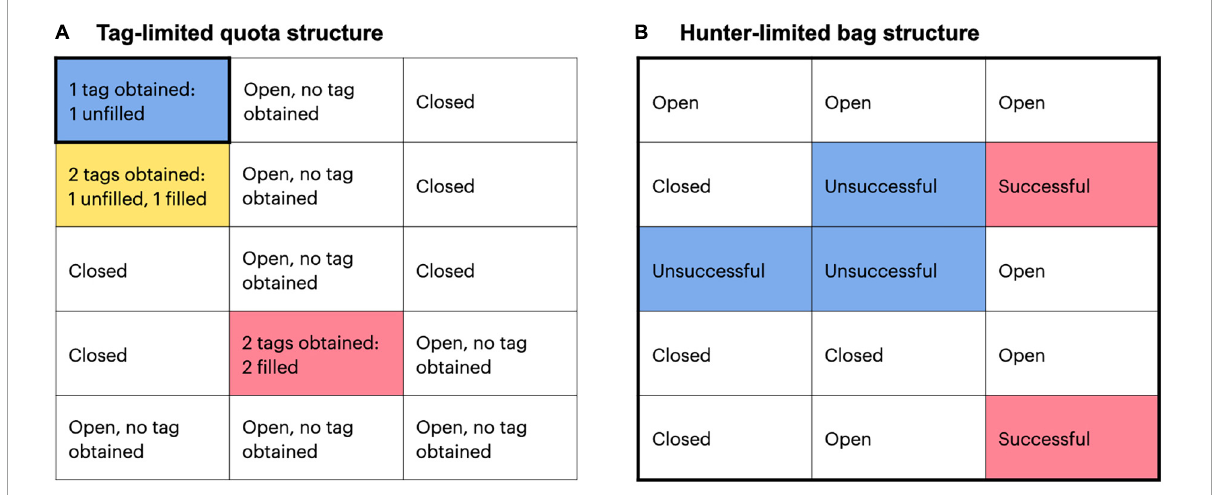
FIGURE2 Hypothetical examples of harvest data recording for (A) quota structure and (B) bag structure, where the outer square represents a large spatial scale, such as a state, nested rectangles represent deer management units, and the thicker border represents the spatial scale of tag issuance. Units can be Open or Closed to hunting, and given that hunters attempt to fill their tags, hunters can be (A) unsuccessful (blue), successful (red), or partially successful (yellow), or (B) unsuccessful (blue) or successful (red) within a unit. In panel (A) , hunter success can be estimated because the scale of tag issuance is the same as recorded harvest. In panel (B) , tags are issued at the large spatial scale, but harvest is recorded within each management unit; hunter success can only be estimated if unsuccessful units are also